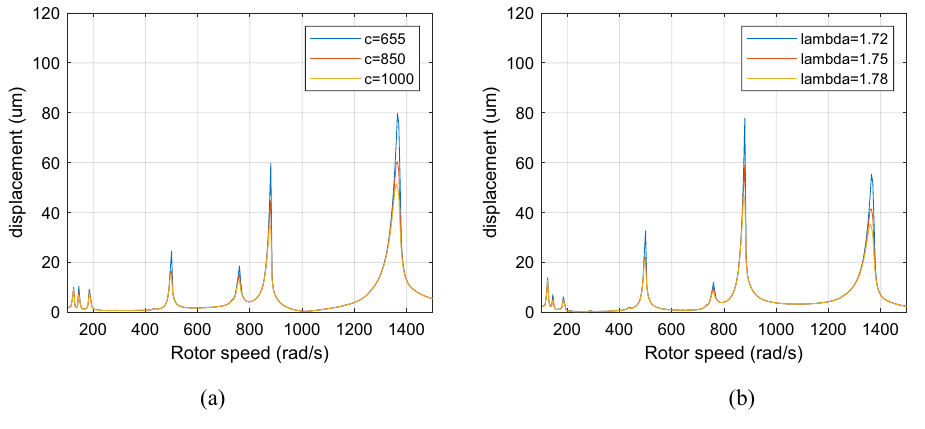
Figure 20. Amplitude-frequency response curve (λ = 1. 75, F 0 = 100, A max = 200) ( a ) LP rotor ( b ) HP